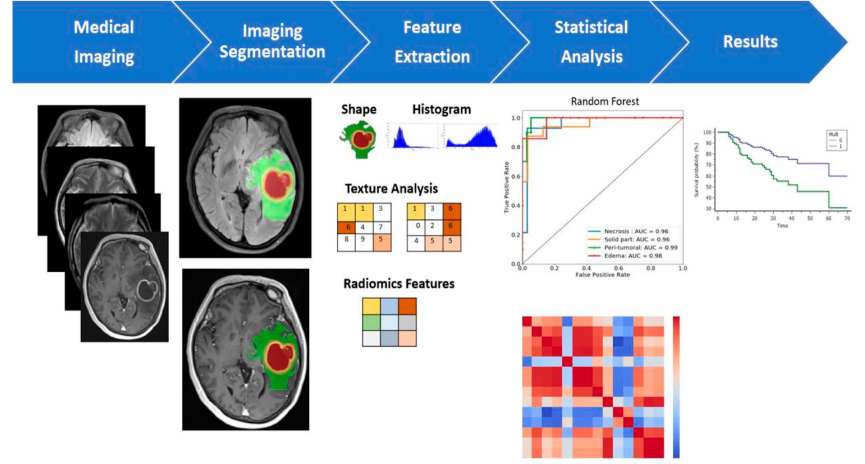
Figure 13. Multiparametric MRI-based radiomic analysis. A multiparametric MRI-based